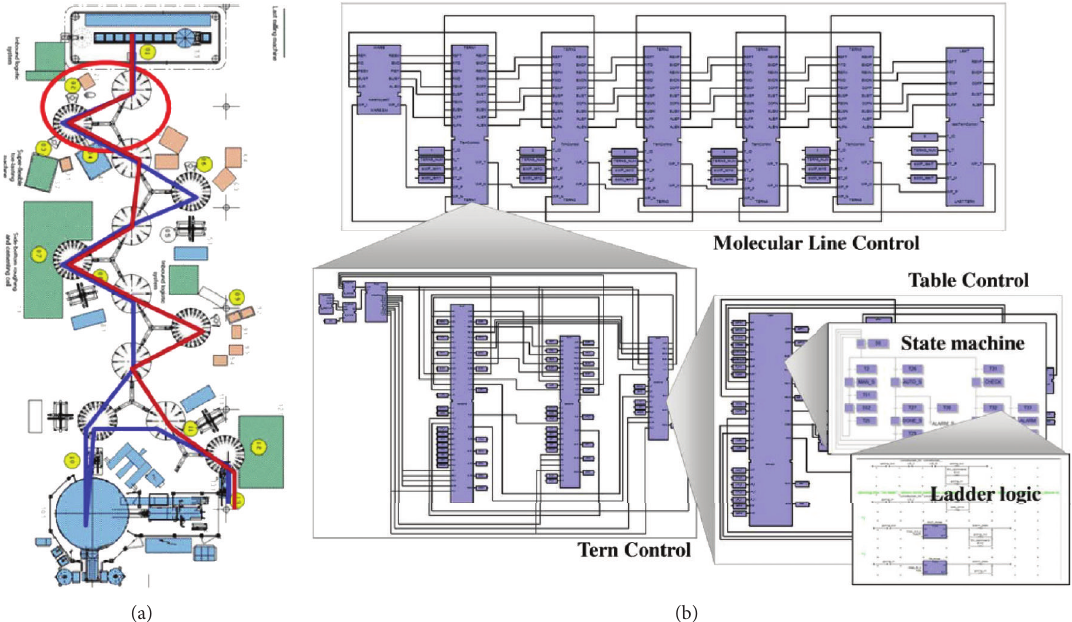
Figure 6: (a) Product flows through the “molecular line” and (b) function block control enabling the flexibility of the “molecular line”